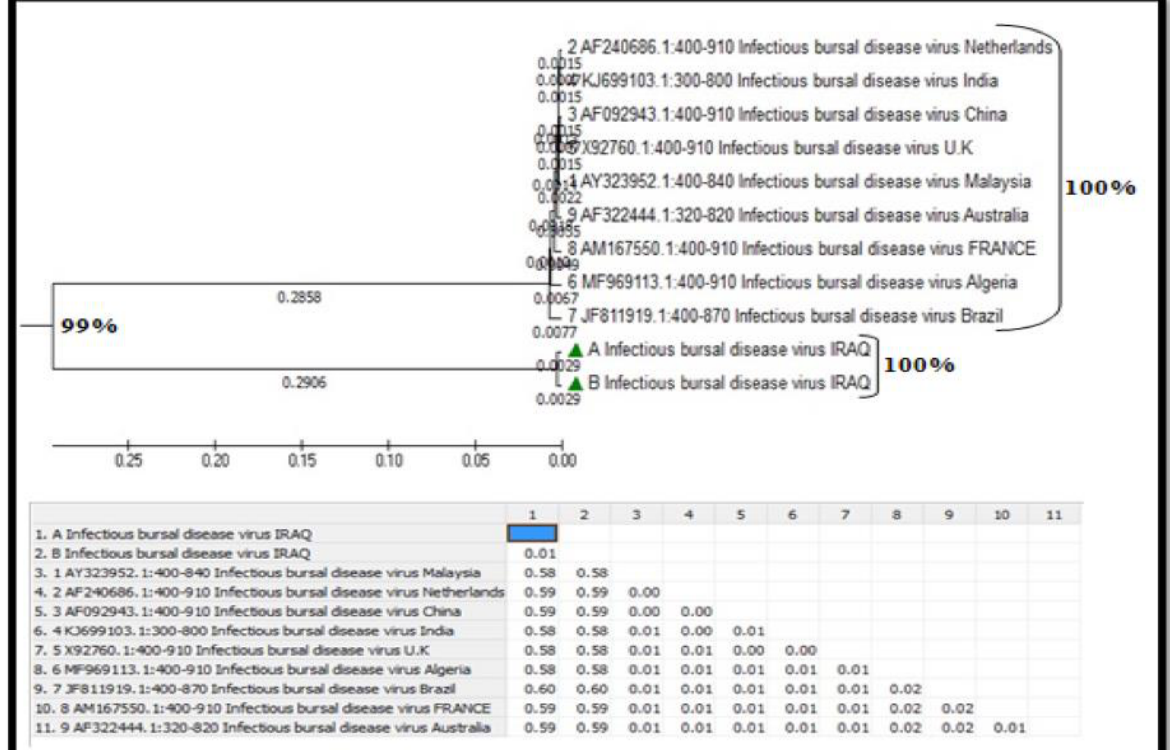
Figure 5. Phylogenetic tree of VP 5 gene of two Iraqi isolates